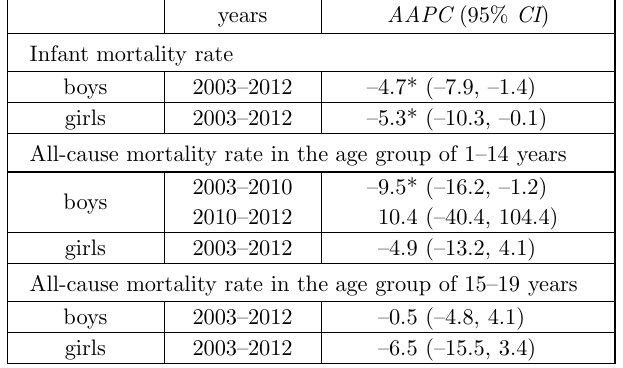
Table 2. Trends in overall mortality rates in the age range of 0–19 years, by age and gender in the Podlaskie Voivodeship from 2003–2012 years AAPC (95% CI